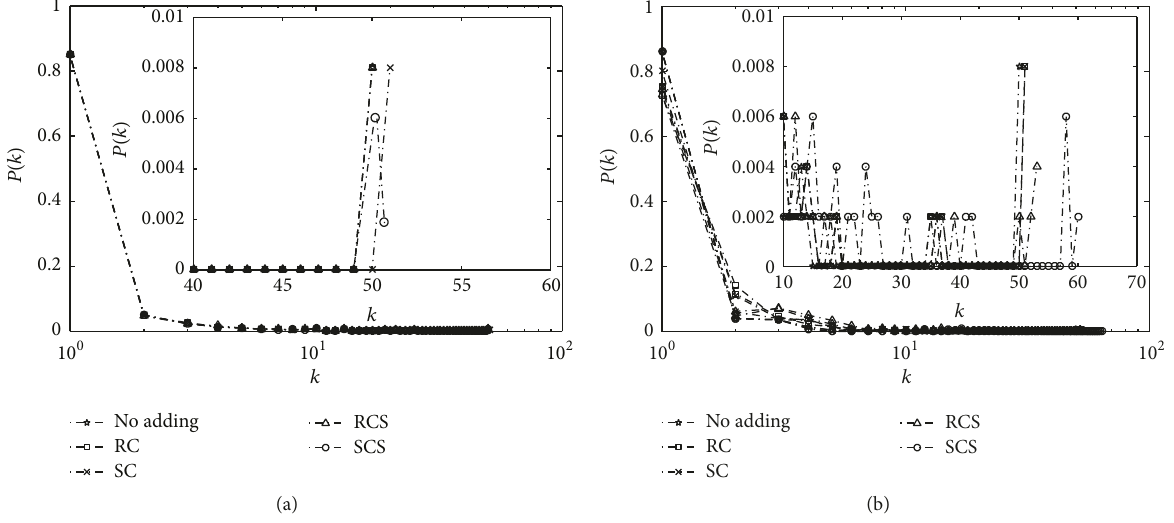
Figure 6: Degree distribution of the network with 𝑞 = 0.01 and 𝑞 = 0.1 . (a) 𝑞 = 0.01 . (b) 𝑞 = 0.1 .